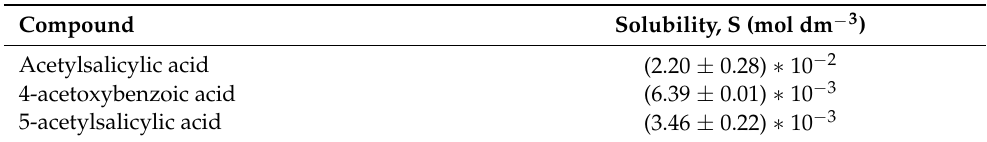
Table 1. Solubilities of acetylsalicylic acid, 4-acetoxybenzoic acid and 5-acetylsalicylic acid in water at 298.15 K.